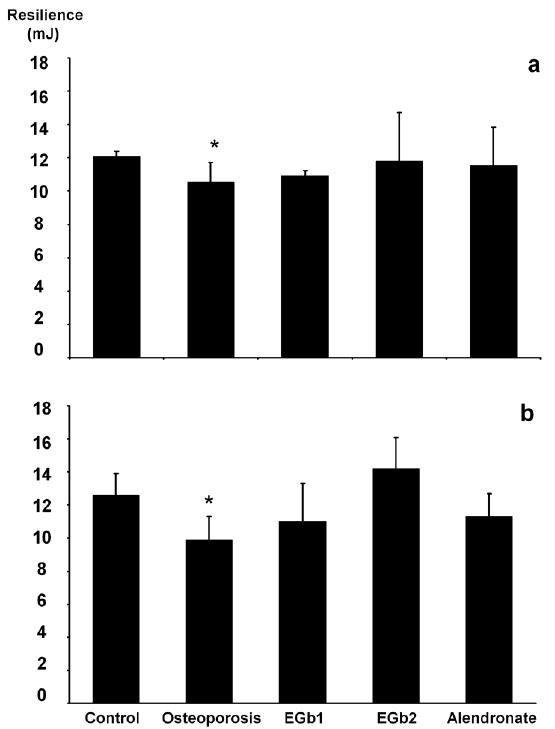
Figure 5 - Mechanical properties of the three-point bending test- resilience. a - 20 days of treatment. b - 30 days of treatment. *p<0.05 when the control group was compared to the osteoporosis group (Student`s